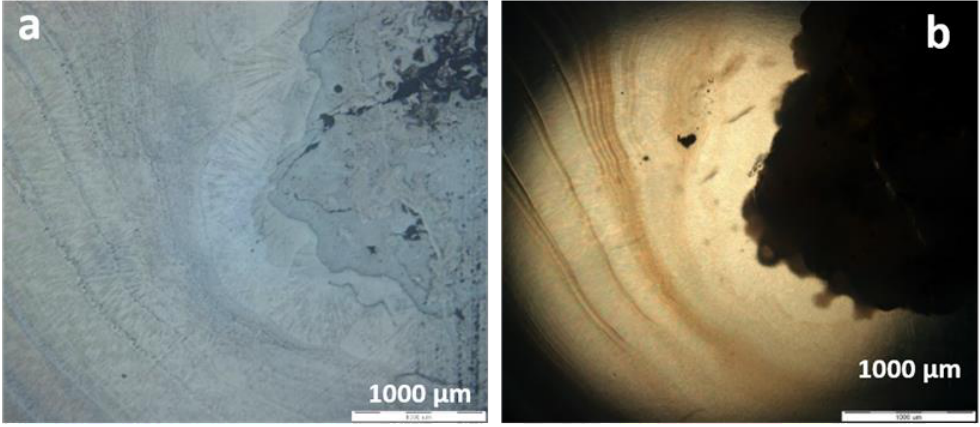
Figure 6. Microstructure of agate No. 4 (Figure 4b) near rock fragments: ( a ) in reflected light; ( b ) in transmitted light. A thin section of the agate.